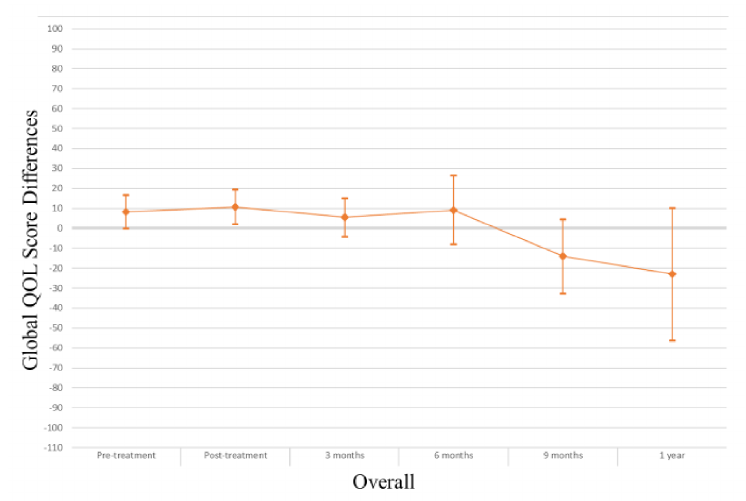
Figure 1. Global QOL score differences in overall study